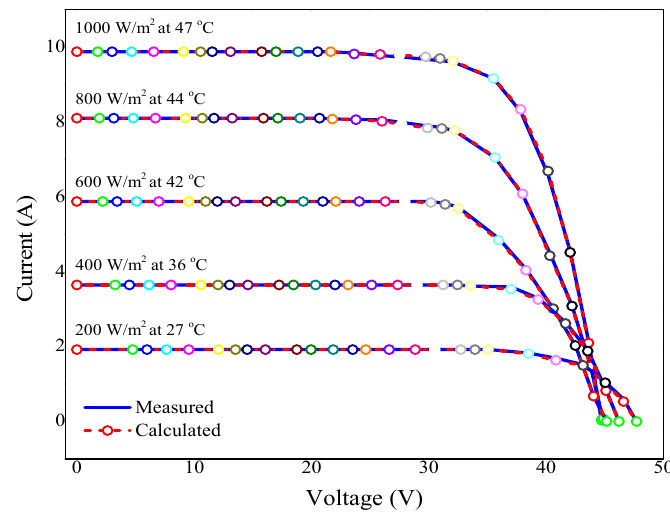
Figure 18. I–V curves of the measured and the calculated currents for the double-diode practical system at different irradiance and temperature levels. Table 18. I–V values and the relative IAE for the double-diode JKM330P-72, 310 W polycrystalline PV